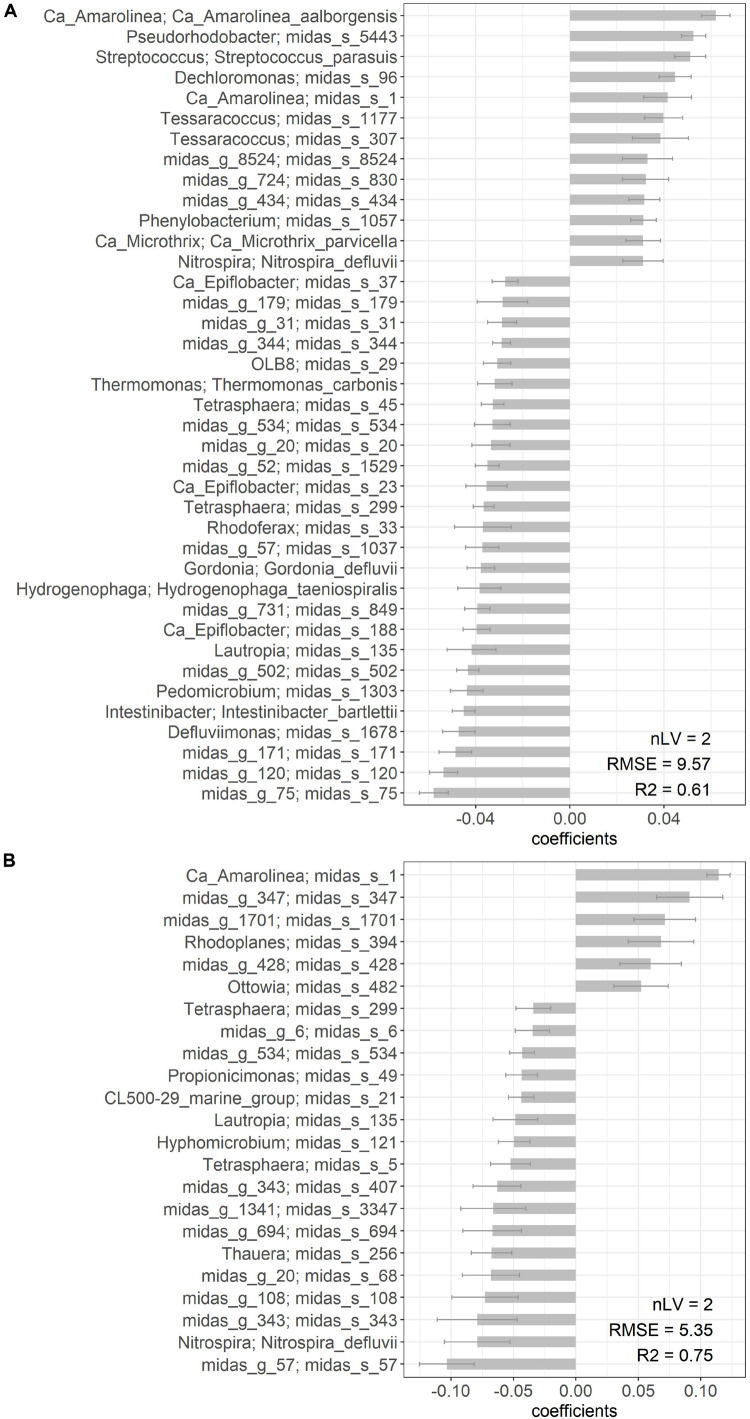
List of species significantly (P < 0.05) contributing to the PLS estimation of DSVI parameter in (A) Aalborg West and (B) Bjergmarken. The number of selected component (latent variables, nLV), root mean square error (RMSE), and R2 for the cross-validation results are indicated.